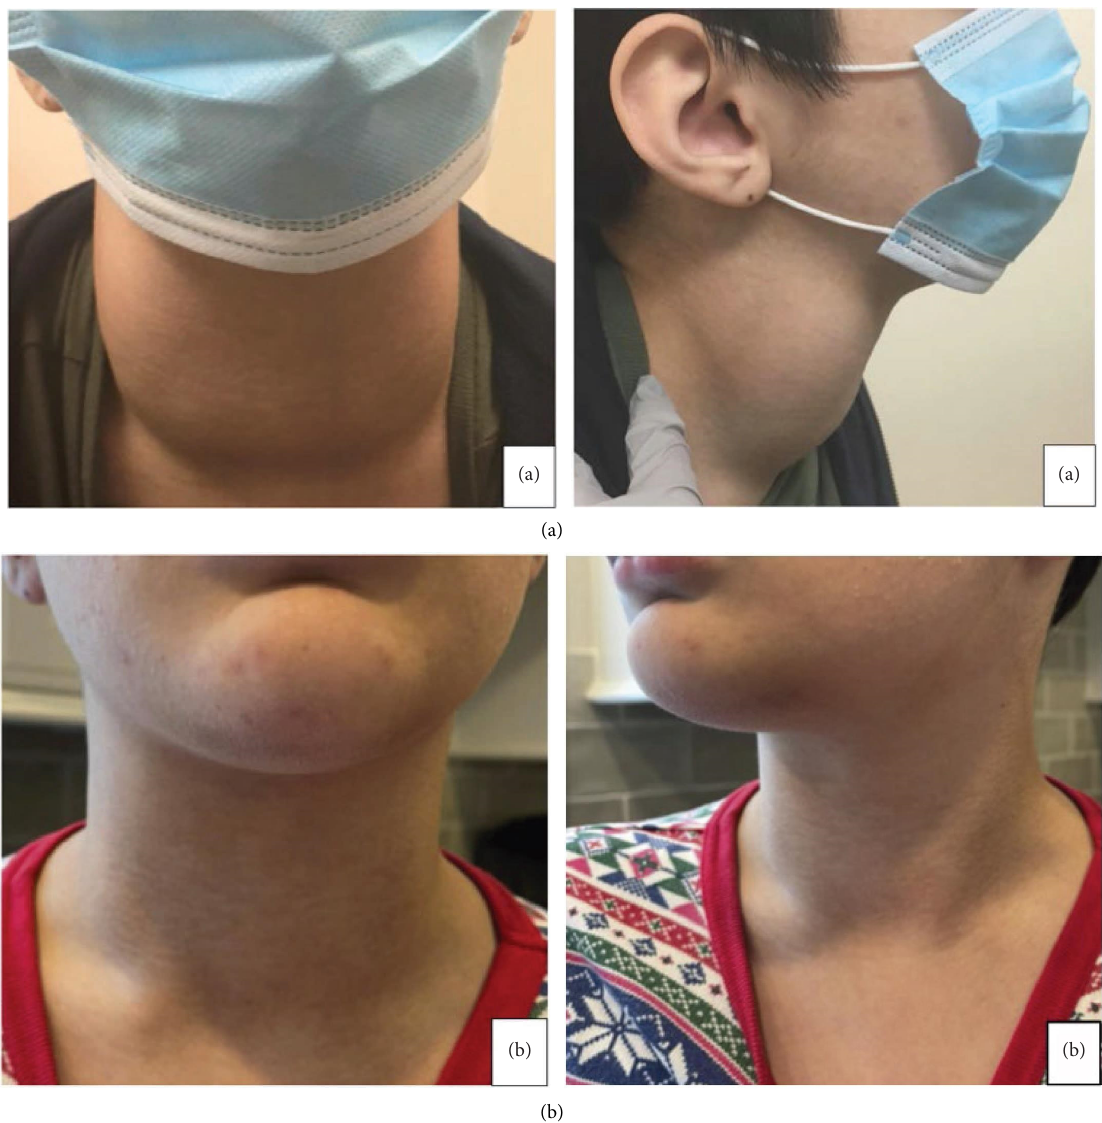
Figure 1: (a) Visible goiter at the initial endocrinology visit and (b) virtual follow-up two weeks after treatment